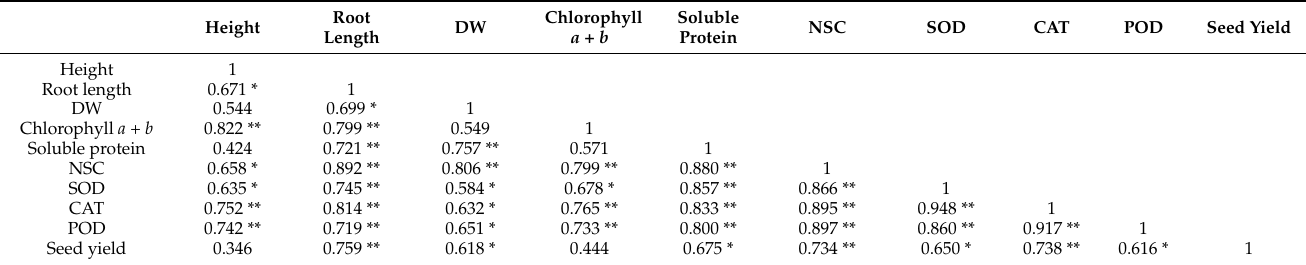
Table 5. Correlation between height, root length, DW, chlorophyll a + b , soluble protein, NSC, SOD, CAT, POD and seed yield of sesbania pea at 138 DAP grown in saline soil.